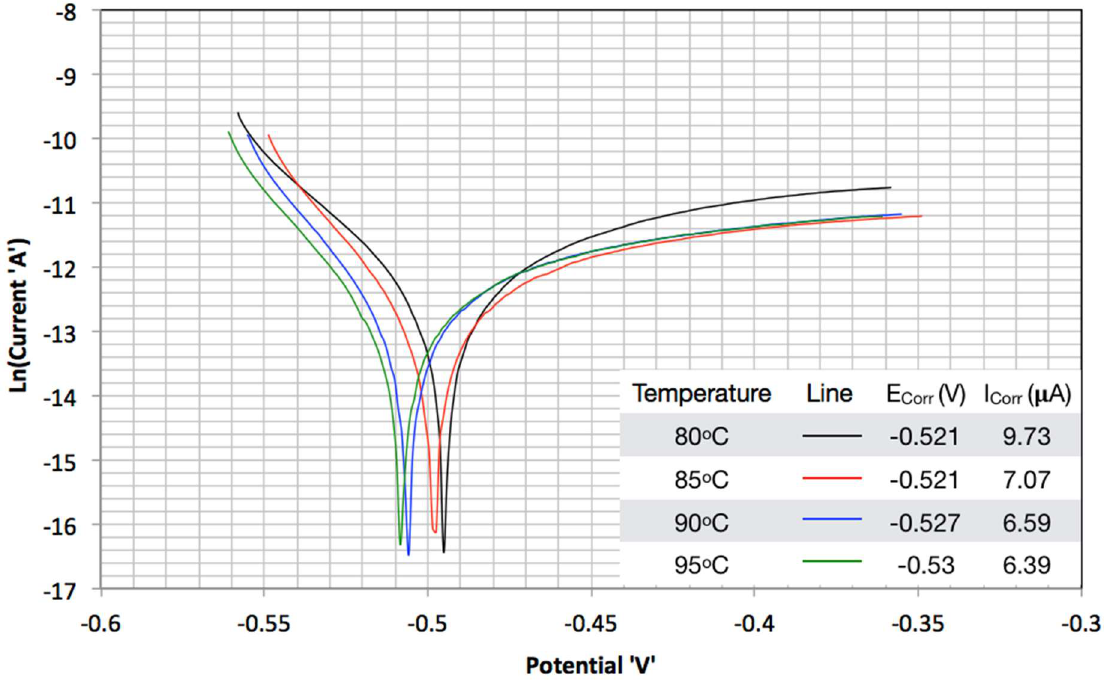
Figure 4. Tafel curves of [bmim][MS] and 10% methyl diethanolamine (MDEA) without CO 2 at different temperatures. Scan rate = 1 mV/s. Fitted results for corrosion rates and potential are provided in the table.